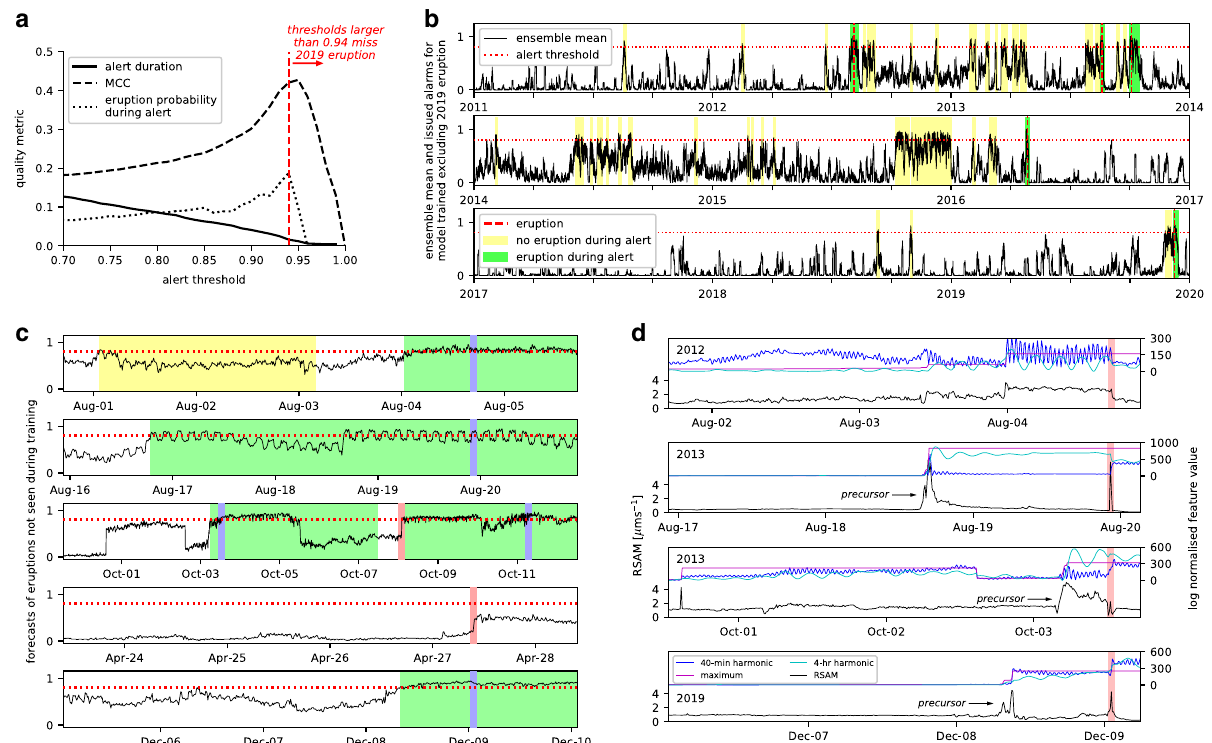
Fig. 2 Whakaari eruption forecast model. a Quality metrics as a function of alert threshold for a model trained excluding the December 2019 eruption: MCC = Matthews correlation coef fi cient, a balanced quality metric similar to r 2 (see “ Methods ” ); eruption probability during alert = proportion of all raised alerts that contain an eruption; alert duration = fraction of analysis period during which the forecast model is in-alert. The red dashed line indicates an alert threshold above which the December 2019 eruption would have been missed. b Performance of the same model over the analysis period for a threshold of 0.8 (red dotted line). Ensemble mean (black), eruptions (vertical red dashed lines), and alerts with (green) and without eruptions (yellow) are shown. c Performance of forecast models under cross-validation, anticipating four out of fi ve eruptive periods ( fi ve out of seven eruptions) when that eruptive period is excluded from training. As in ( b ), the alert threshold is 0.8. Missed eruptions are indicated in red, the remainder in blue. d RSAM signal (black) in the three days prior to the 2012, 2013, and 2019 eruptions, alongside the three feature values from Fig. 1d – f (blue, magenta, cyan). To aid comparison, feature values have been normalized in log space to zero mean and unit standard deviation. Precursor signals identi fi ed by arrows are referred to in the